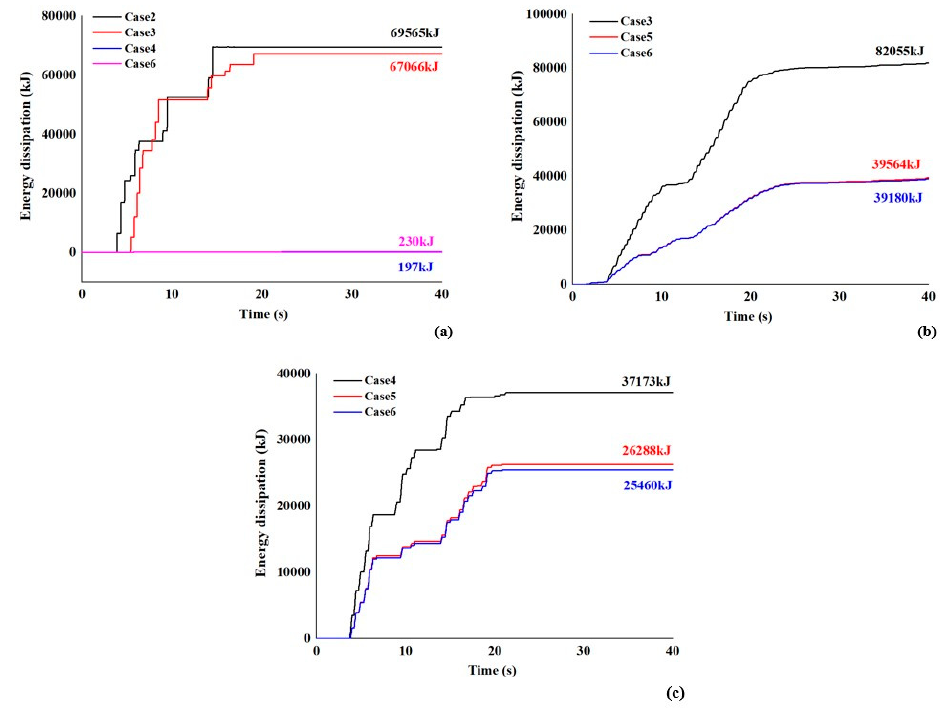
Figure 13. Cumulative energy dissipation of seismic measure: ( a ) energy dissipation of expansion devices, ( b ) energy dissipation of the restrainer, ( c ) energy dissipation of the unseating prevention device.